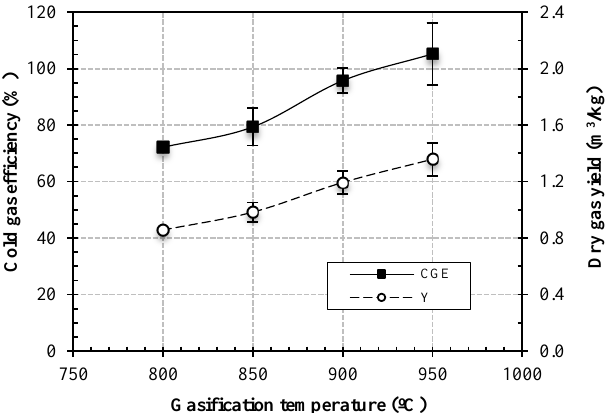
Figure 4. Effect of gasification temperature on cold gas efficiency and dry gas yield.